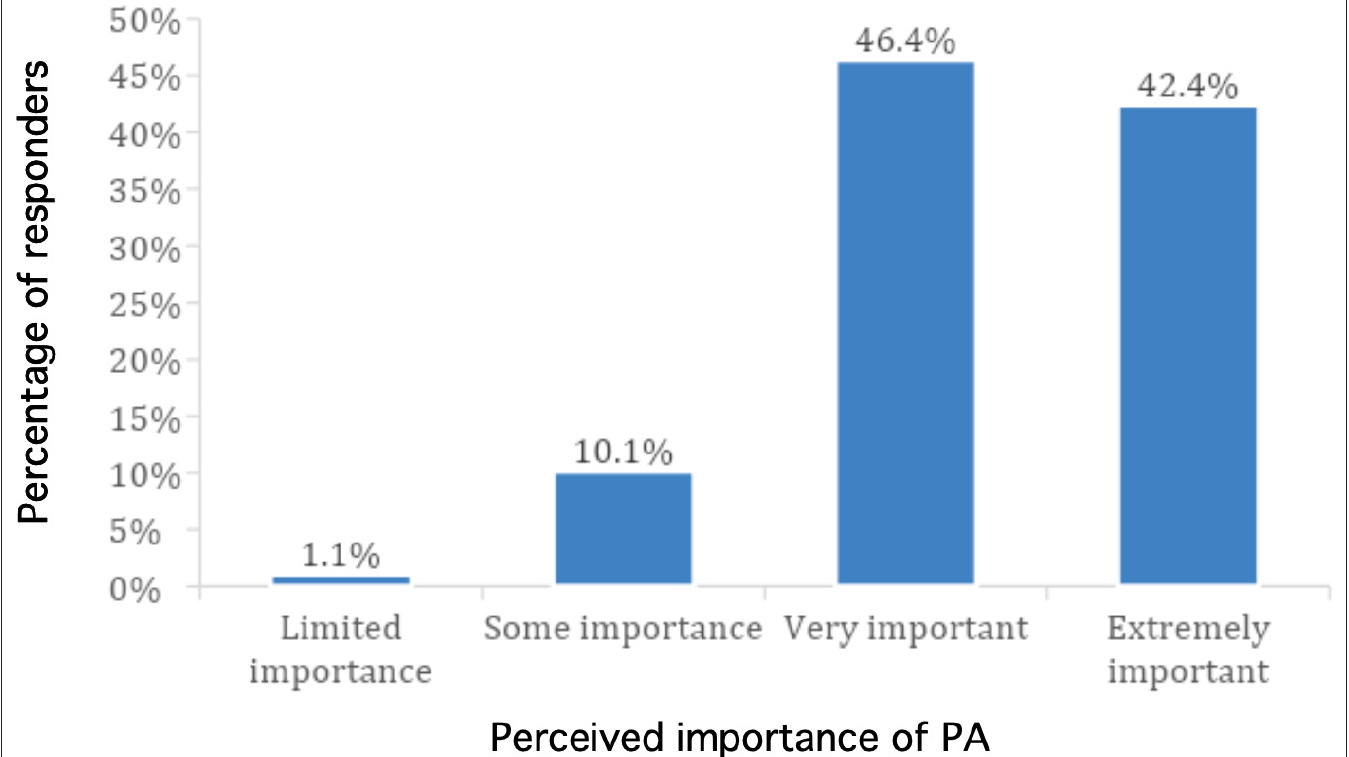
Figure 1 Perceived importance of physical activity (PA) for the prevention and management of health